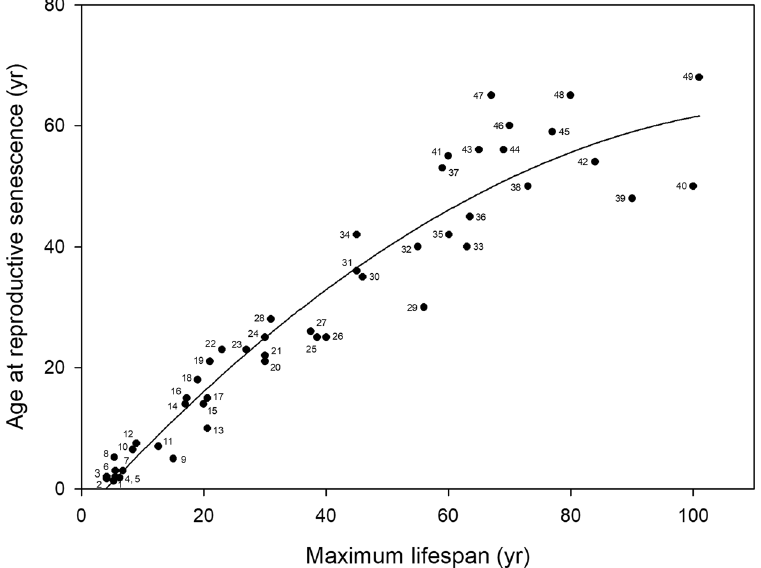
Figure 1. Age at reproductive senescence (yr) versus maximum lifespan (yr) in 49 mammal species (excluding baleen whales). Data points fitted by a quadratic regression (line; RS = − 4.4535 * + 1.1168 LS ***